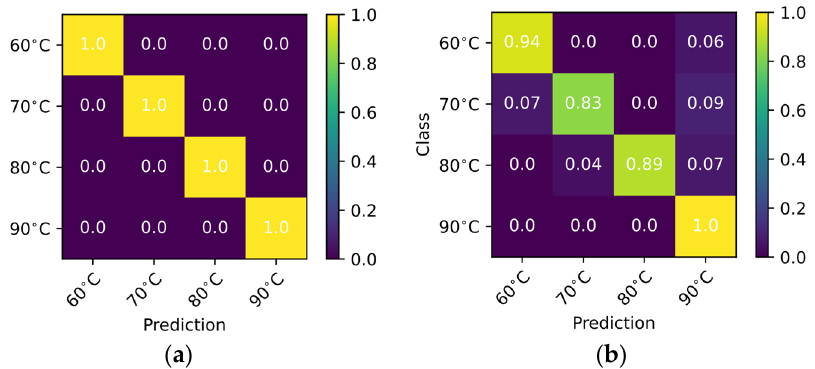
Figure 6. Confusion matrix of the MobileNet model for greyscale ( a ) and RGB color space ( b ) calculated from the training set.